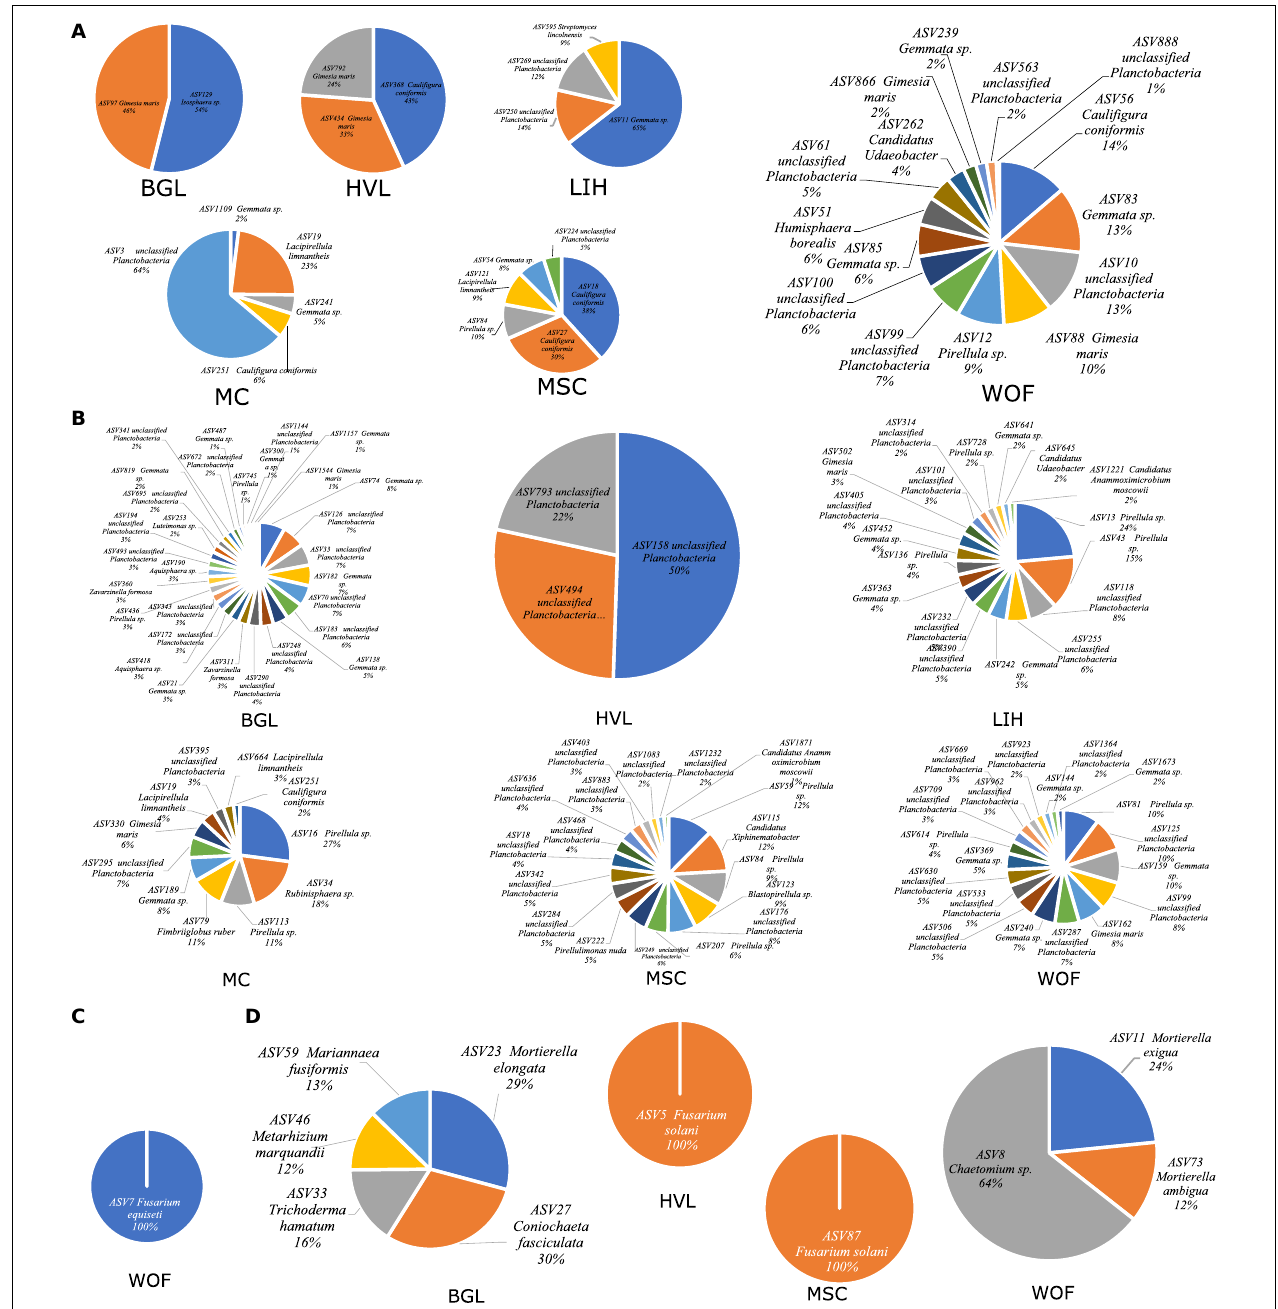
FIGURE 6 | Indicator species of hemp microbiome. The most representative species of hemp microbiome were identified through indicator species analysis in six different field locations. Bacterial indicator species in root (A) and in rhizosphere soil (B) ; and fungal indicator species in root (C) ; and in rhizosphere soil (D) . Fungal indicator species in root identified only in WOF filed. Three replicates were used for analyzing indicator species in each